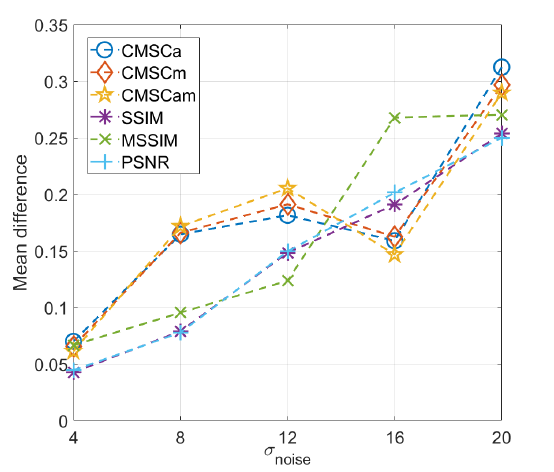
Figure 2. Average values of the absolute difference of parameters found by no-reference mutual information metrics and by full-reference metrics on TID database